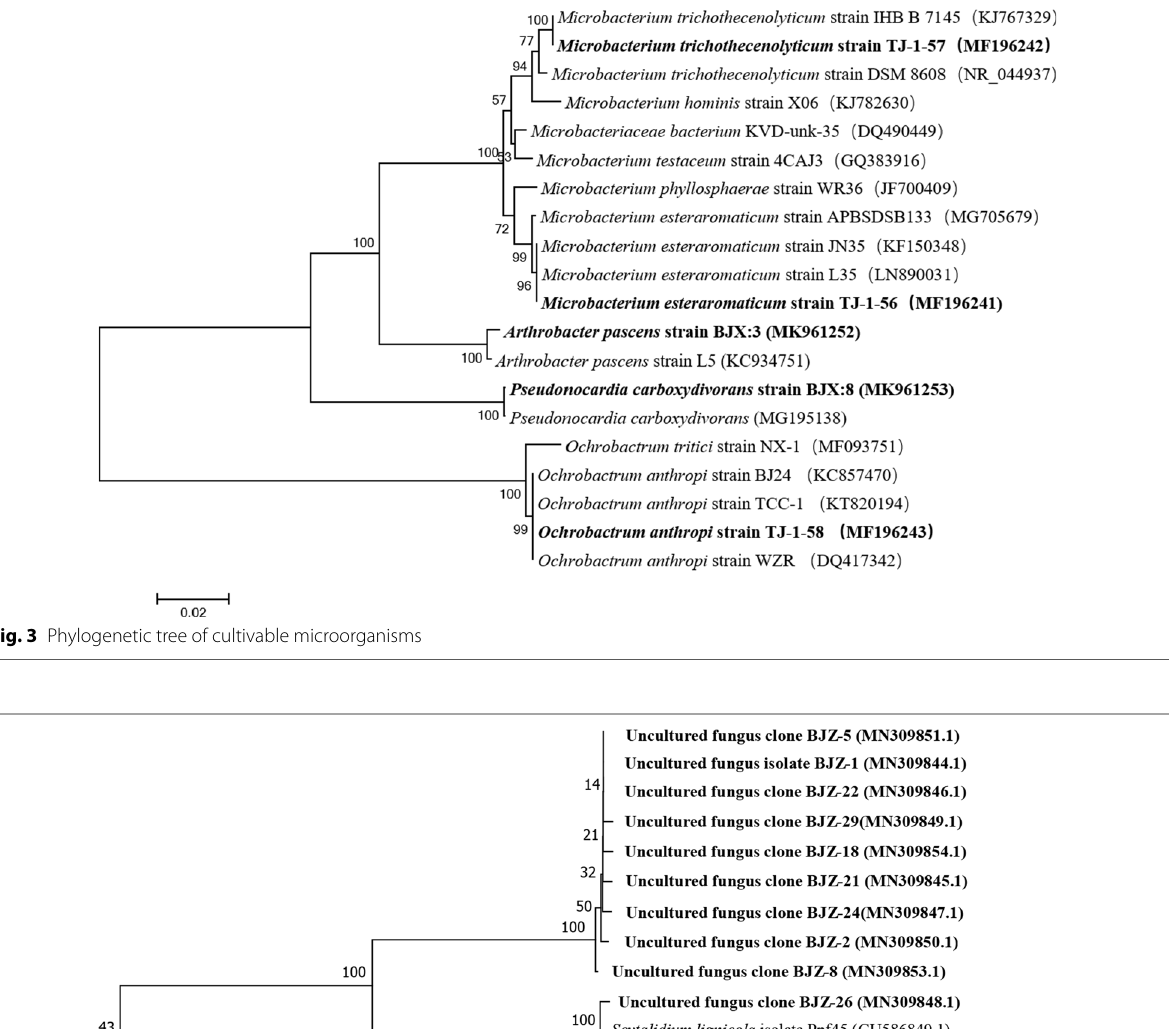
Fig. 4 Phylogenetic tree of HTPB degrading fungi constructed by molecular clone